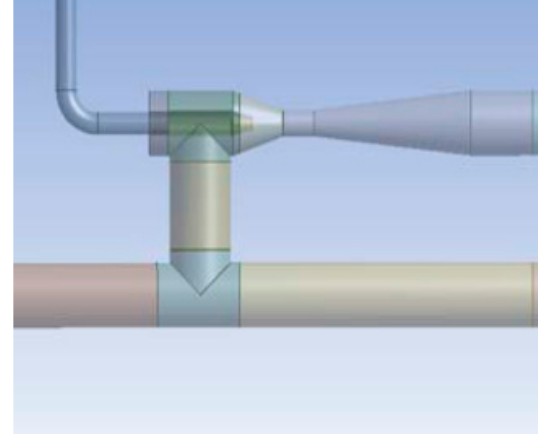
Figure 7. Simulation domain of jet pump.